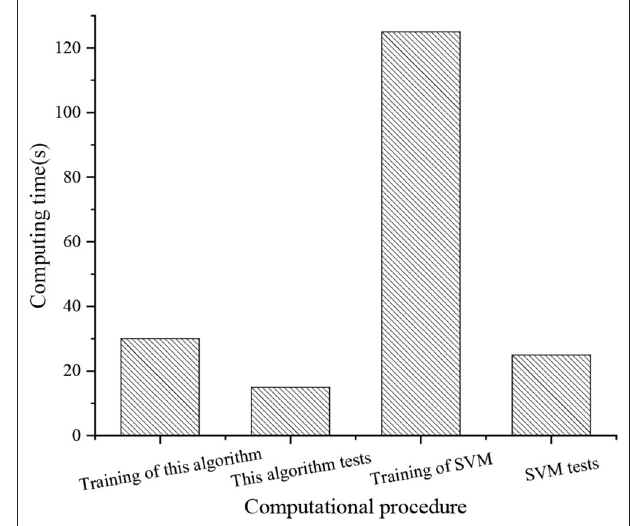
FIGURE 13 | Comparison of recognition rate under different algorithm feature fusion strategies.